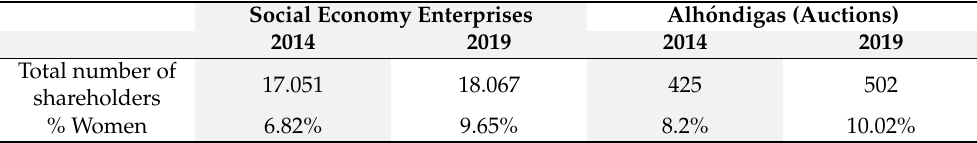
Table 1. Shareholders.